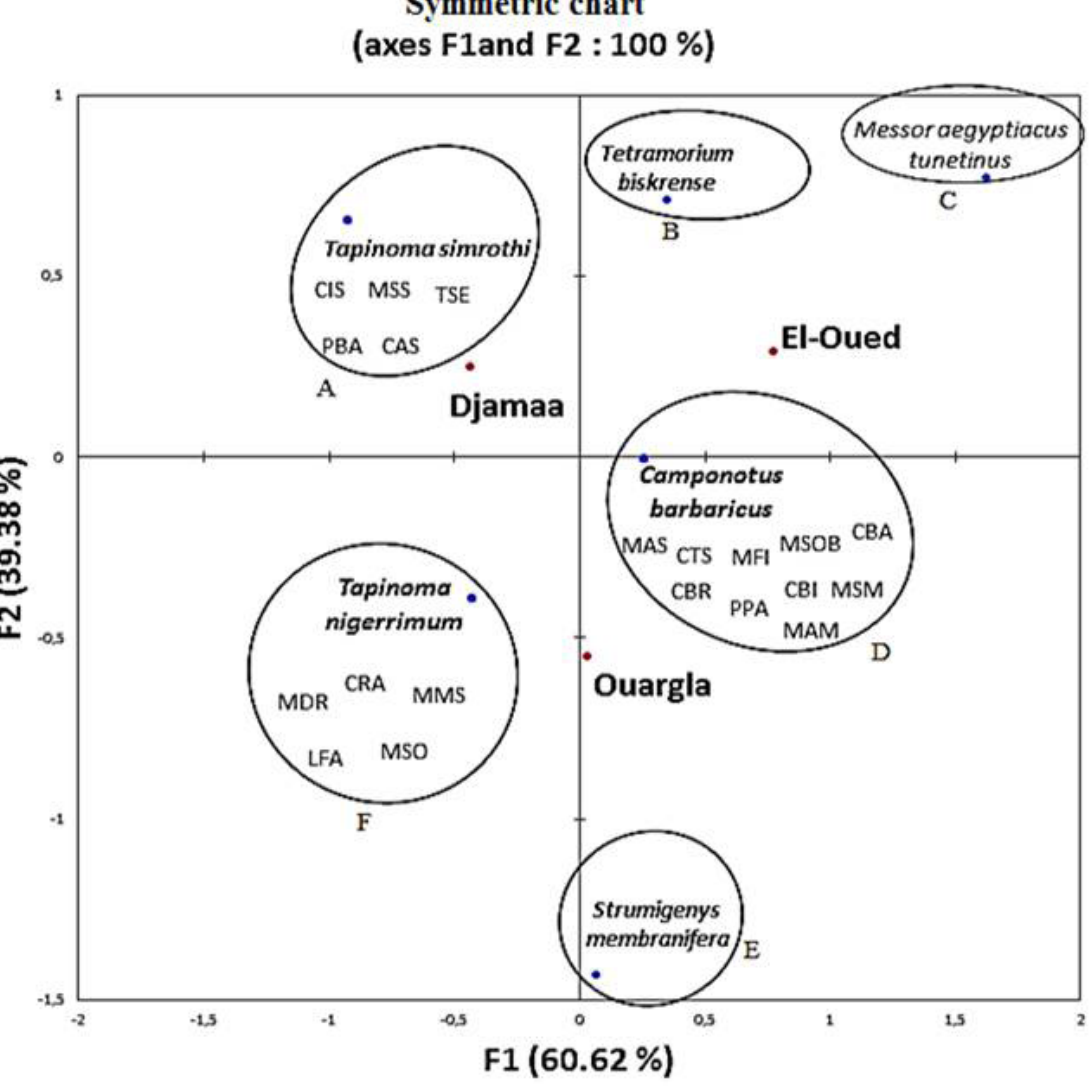
Fig 1. Chart represents factorial map of the repartition of ant species in the study region CAS: Cataglyphi s albicans , CBA: Cataglyphis bombycina , CBI: Cardiocondyla batesii, CBR: Cataglyphis bicolor , CIS: Crematogaster inermis , CRA: Cataglyphis rubra , CTS: Camponotus thoracicus , LFA: Lepisiota frauenfeldi atlantis , MAM : Monomorium areniphilum , MAS: Messor arenarius, MDR: Monomorium destructor , MFI: Messor foreli , MMS: Messor medioruber sublaeviceps , MSM: Monomorium subopacum , MSO: Monomorium salomonis obscuratum , MSOB: Monomorium salomonis obscuriceps , MSS: Messor sanctus , PBA: Plagiolepis barbara , PPA: Pheidole pallidula , TSE: Tetramorium sericeiventre